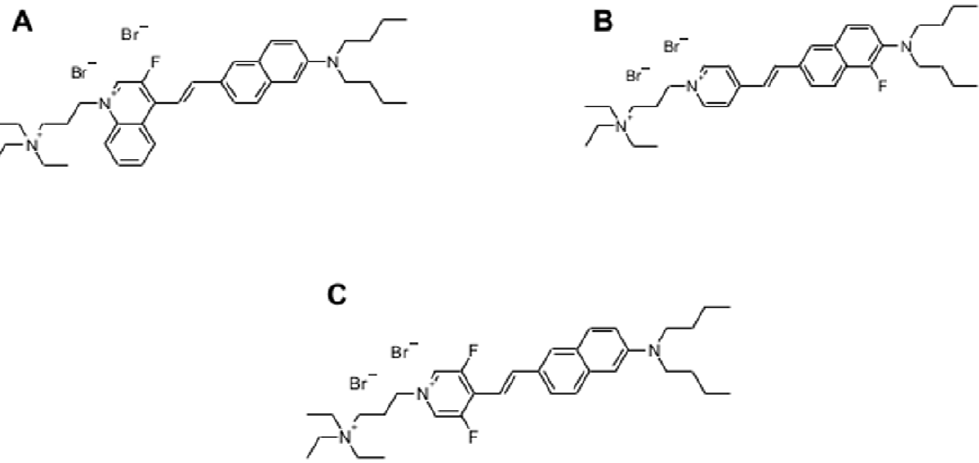
Figure 1. Structures of fluorescent probes. The structure of PY3304 (A), PY3174 (B), PY3184 (C).